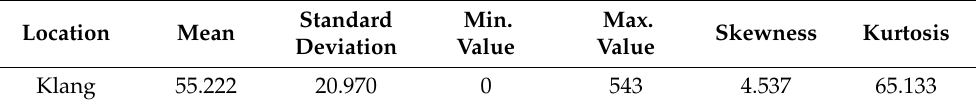
Figure 3. Time series plot corresponding to unhealthy air pollution event threshold. Table 2. Descriptive statistics of API data in the Klang area.